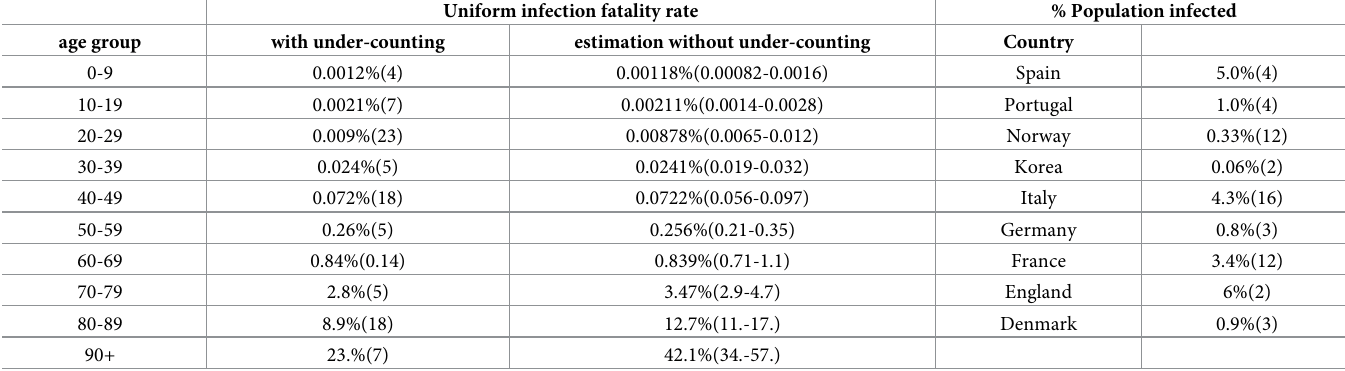
Table 1. Estimations assuming a uniform attack rate. We show our estimation for the uniform infection fatality rate (UIFR) before and after quantifying the effects of the systematic under-counting of deaths. We also estimate the percentage of the population infected in each country by the end of May of 2020. Errors include the statistical error ( ± sigma , the standard deviation obtained through error propagation of the results in Table 1, and the uncertainty of the prevalence survey in Spain) and a systematic error of 35% of possible under-counting of deaths, see Section